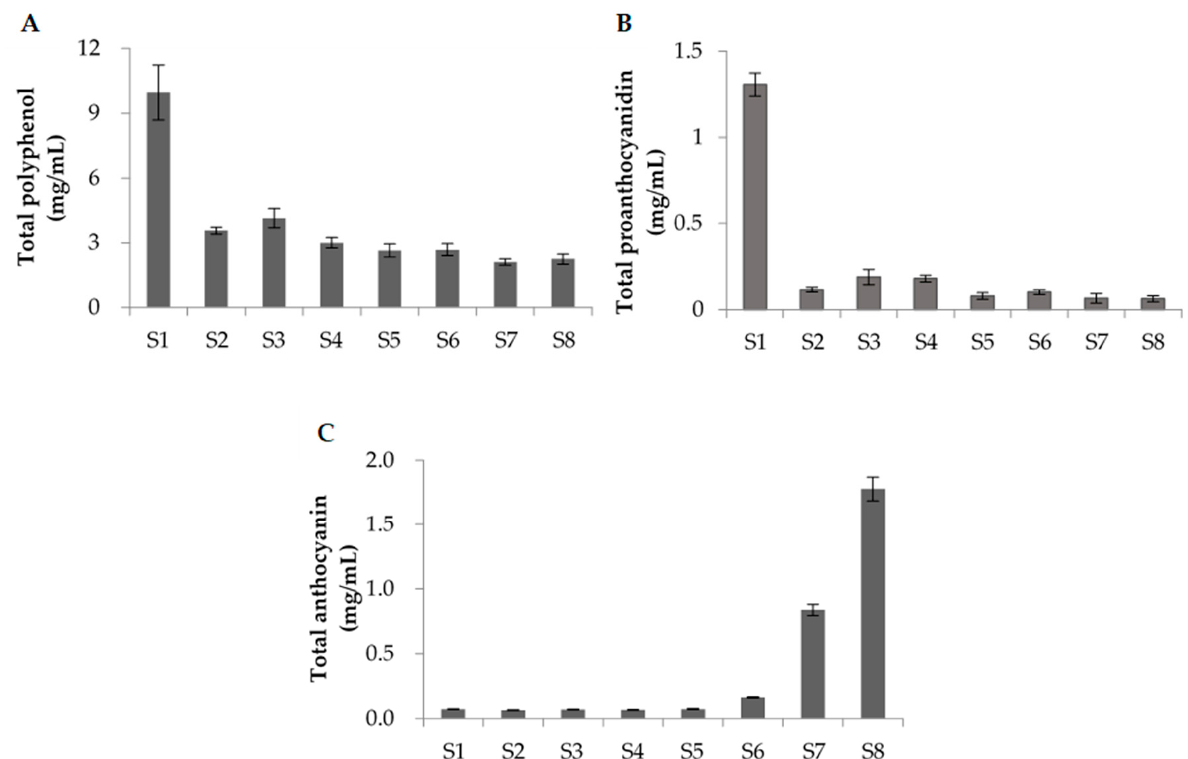
Figure 3. Quantification of the amounts of polyphenol compounds during ripening stages S1–S8. ( A ) The total polyphenol content was determined by the Folin-Ciocalteu method. Data represent mg of gallic acid equivalents per 100 mg/mL DMSO solution of the raspberry fruit extract. ( B ) The total proanthocyanidin content was determined by a modified protein precipitation method. Data represent mg of procyanidin B2 equivalents per 100 mg/mL DMSO solution of the raspberry fruit extract. ( C ) The total anthocyanin content was measured using fruits extracted with methanol containing 5% formic acid. Data represent mg of cyanidin chloride equivalents per 100 mg/mL DMSO solution of the raspberry fruit extract. Error bars represent the standard deviation (SD) of the mean ( n = 8).